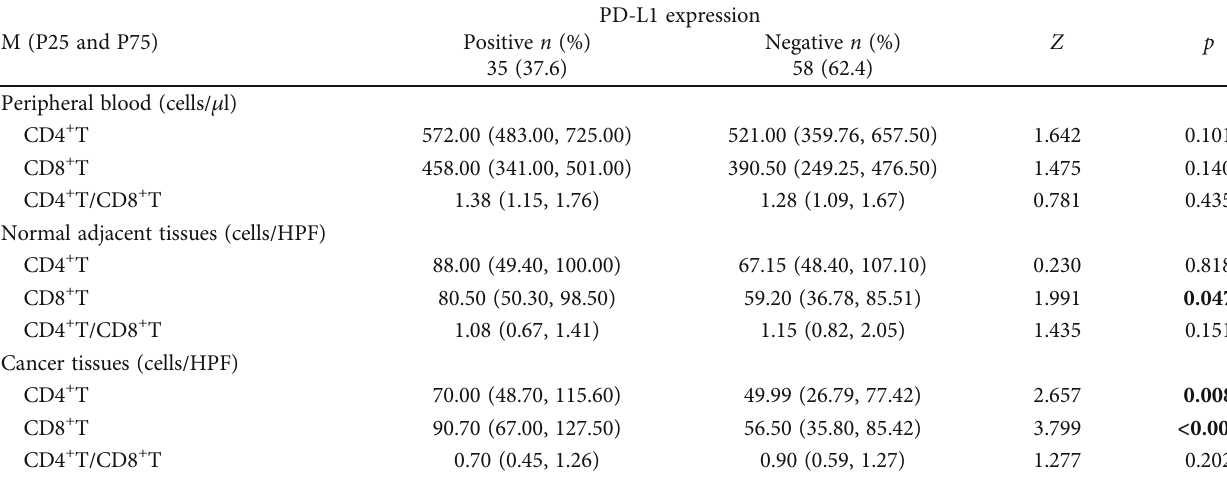
Table 4: Connection between PD-L1 expression in cancerous cells and the cell count of CD4 + T and CD8 + T in peripheral blood, surrounding tissues, and cancer